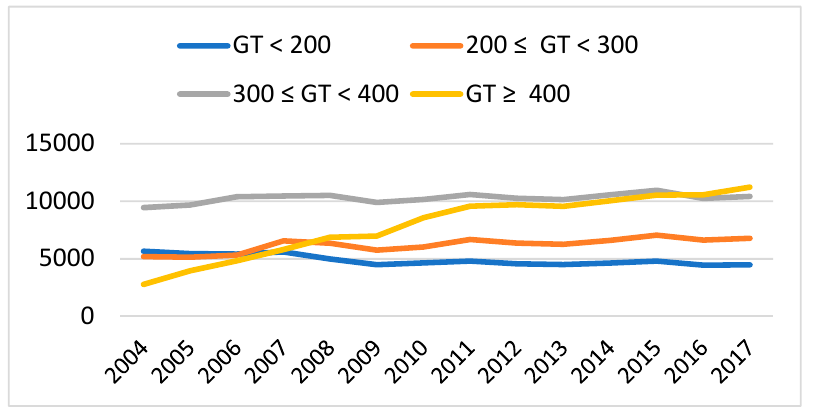
Figure 6. Evolution of emissions of the Spanish tugboat fleet, by groups of size, measured in GT.